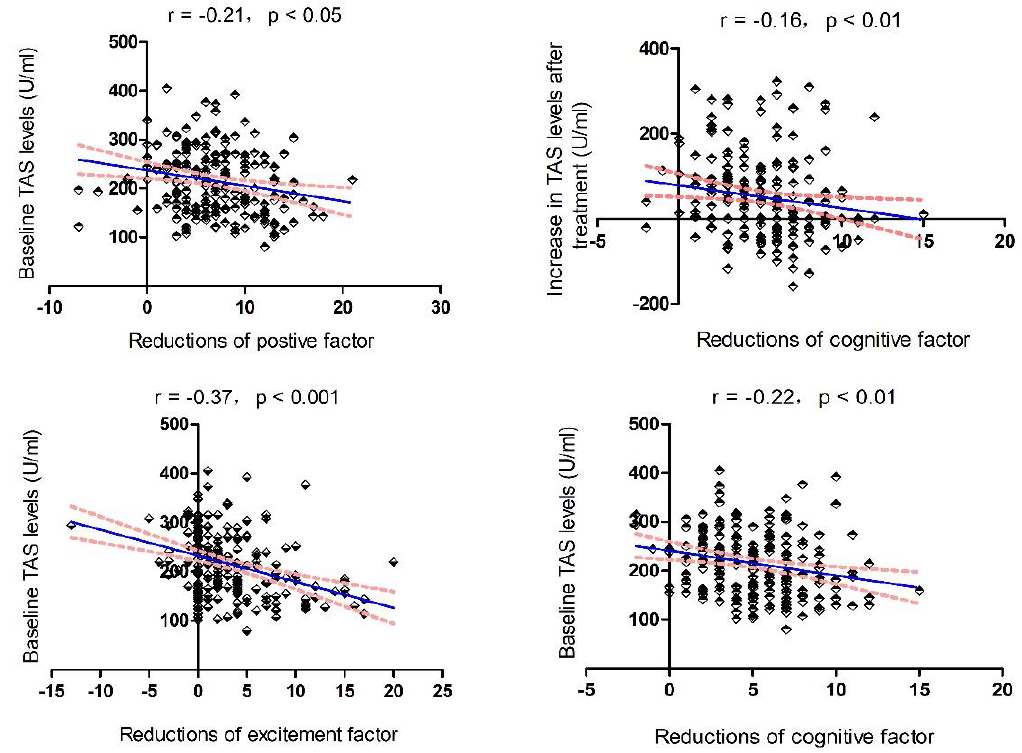
Figure 1. Associations between TAS levels and cognitive improvements. The red line is the trend line and the blue dashed line is the 95% confidence interval.